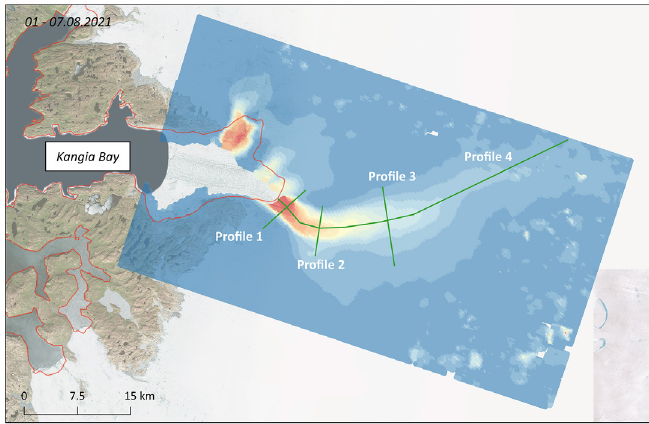
Fig. 9. Location of